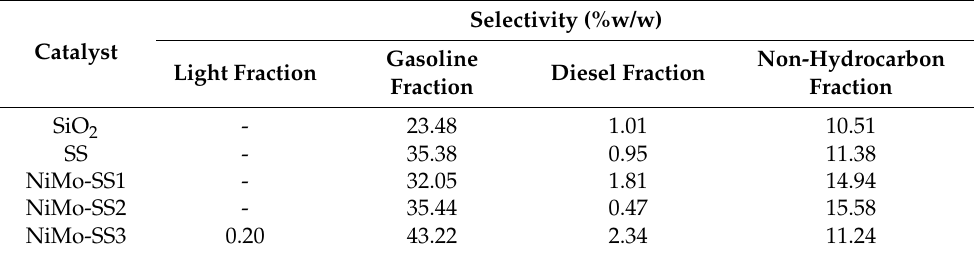
Table 5. Catalyst selectivity test from the catalytic hydrocracking of fresh frying oil. Table 6. Comparison data of liquid yield in the hydrocracking